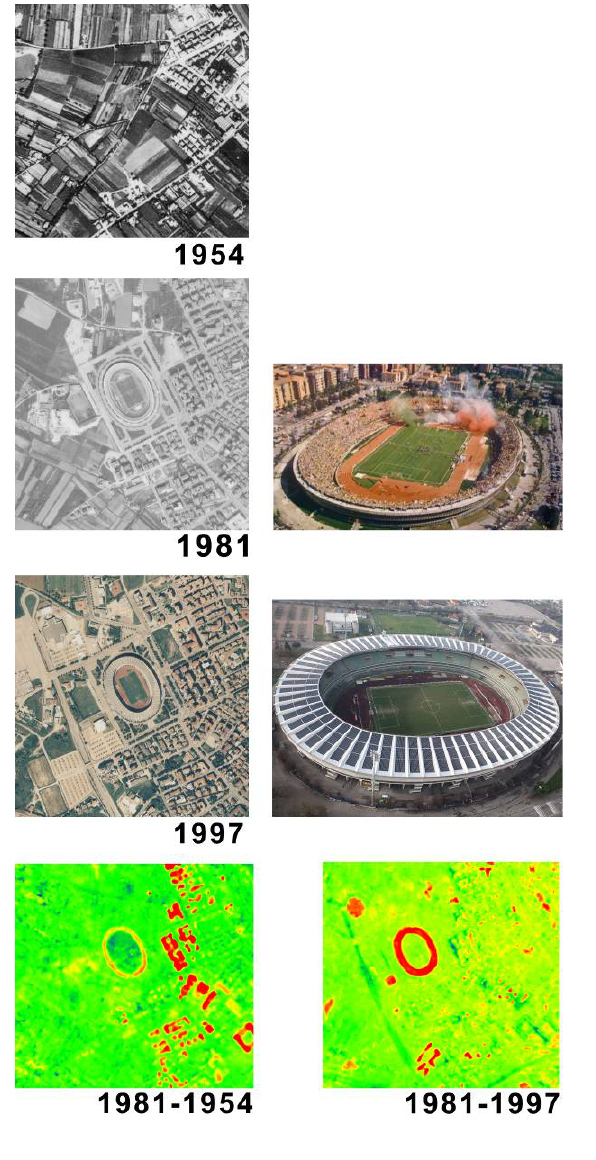
Figure 5: Example of city transformation documented by the comparison of 3d models of different period. On the left the extraction from orthofotos of the area of the Stadio Bentegoni in Verona. On the right two images of the stadio before and after changes. At the bottom the maps of